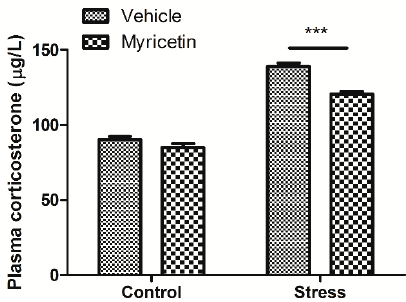
Figure 2. Effects of myricetin on the plasma corticosterone levels of mice subjected to repeated restraint stress for 21 consecutive days. Myricetin treatment reversed the increase in the plasma corticosterone of the mice subjected to repeated restraint stress. Regular two-way ANOVA, drug(myricetin) × treatment(stress) interaction F (1,24) = 8.68, p < 0.01; significant treatment variation F (1,24) = 353.07, p < 0.001; significant drug variation F (1,24) = 28.17, p < 0.001, Boferroni post-test, *** p < 0.001 significant difference between groups.